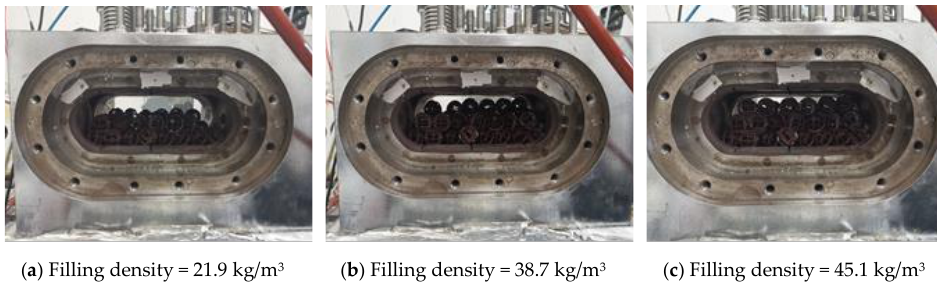
Figure 3. Arrangement modes of NSS with different filling densities in CVCB.